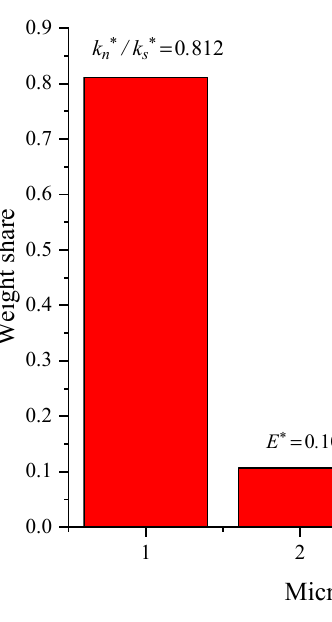
Figure 14. Weight shares of different microscopic parameters for shear strength. As can be seen in the figure, the weight share of 0.812, followed by * E at 0.106, and the weight shares of E and